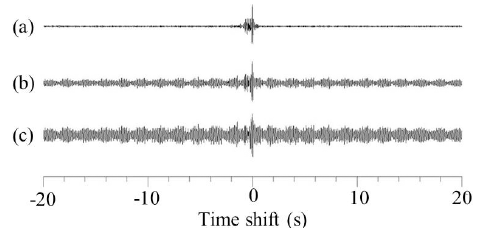
Figure 6. Final EGFs (vertical components) calculated by differ- ent methods of stacking in the time domain for the frequency band 5–10Hz: (a) SNR stacking (SNR = 40); (b) weight stacking (SNR = 15.6); (c) rms staking (SNR =